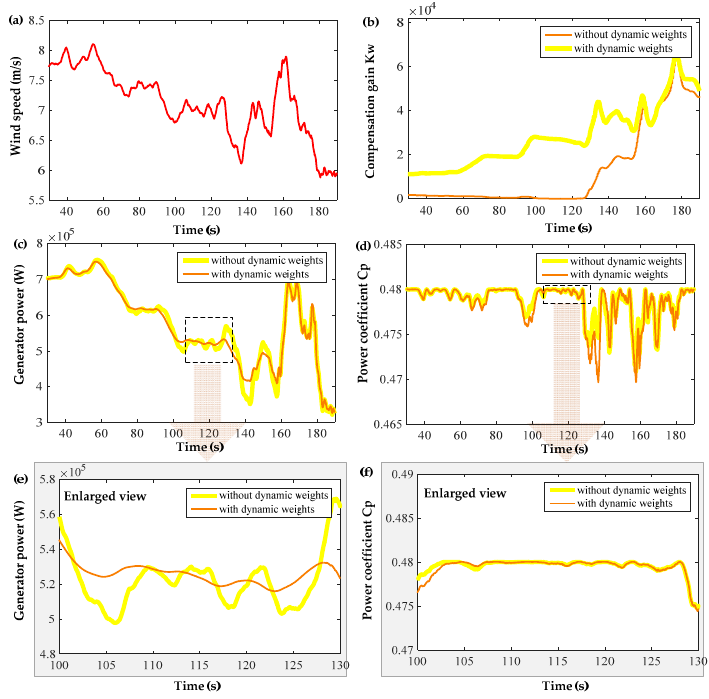
Figure 14. Comparison results with different weights preset methods, ( a ) wind speed; ( b ) compensation gain; ( c ) generator power; ( d ) conversion efficiency; ( e ) enlarged view of generator power; ( f ) enlarged view of conversion efficiency.